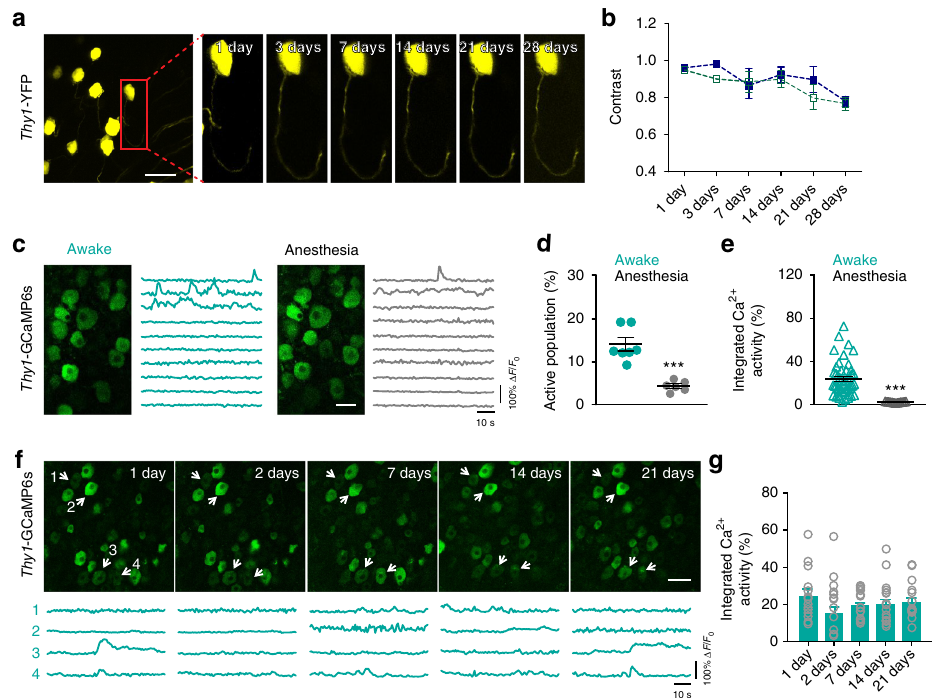
Fig. 3 Chronic two-photon imaging of DRG sensory neurons over time. a Representative two-photon images of DRG sensory neurons expressing YFP. Scale bar, 50 μ m. b Image contrast is depicted as a function of time after surgery ( n = 34 neurons, two mice; each curve represents data from an individual animal). c Representative two-photon images and fl uorescence traces of DRG sensory neurons expressing GCaMP6s in mice under awake (green) and anesthesia (gray) states. Scale bar, 30 μ m. d Percentages of DRG sensory neurons exhibiting Ca 2 + transients in resting awake and anesthetized states (awake: 14.12 ± 1.35%, n = 343 neurons from seven mice; anesthesia: 4.33 ± 0.50%, n = 299 neurons from six mice; t 11 = 6.35, P < 0.001, Student ’ s t- test). e Integrated Ca 2 + activity of spontaneous active neurons in awake (23.37 ± 2.29, n = 48 neurons from seven mice) and anesthetized mice (2.06 ± 0.13, n = 13 neurons from six mice; t = 4.82, P < 0.001, Student ’ s t- test). f Representative two-photon images and fl uorescence traces of DRG sensory neurons 59 expressing GCaMP6s over 21 days. Scale bar, 50 μ m. g Integrated Ca 2 + activity of active neurons over time (1 day: 22.18 ± 3.48, 2 days: 14.11 ± 3.46, 7 days: 20.19 ± 1.69, 14 days: 20.98 ± 2.65, 21 days: 19.46 ± 2.75; n = 109 neurons from three mice; F 2.8,45.4 = 1.629, one-way RM ANOVA followed by Dunnett ’ s multiple comparisons test). Error bars, s.e.m. *** P < 0.001. The source data underlying b , d , e , and g are provided as a Source Data fi